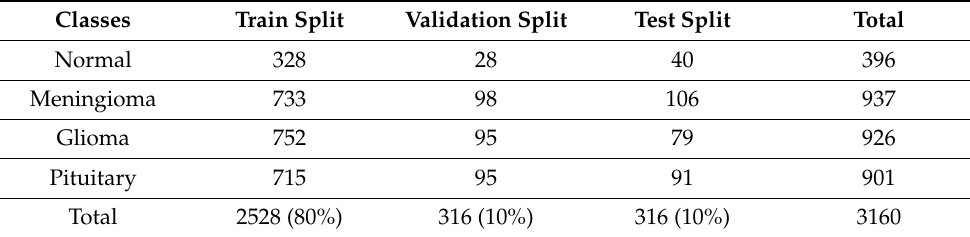
Table 1. Information about DS-1 (Dataset-1) [14].